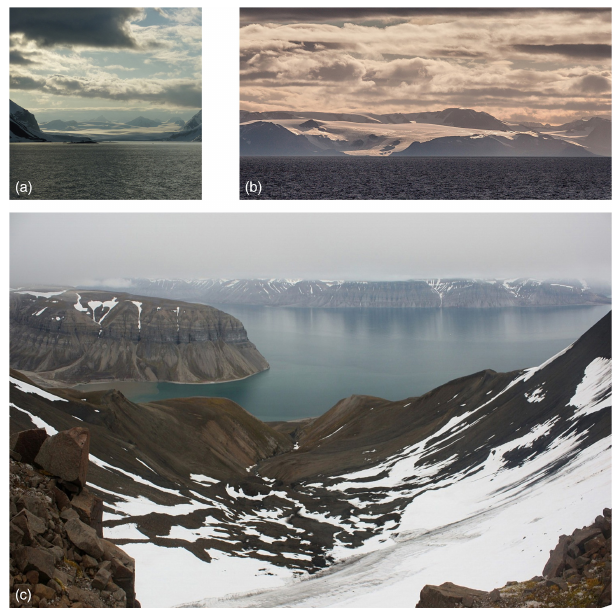
Figure 9. Svalbard landscapes. (a) Hornsund fjord, Spitsbergen, during the RV G.O. Sars expedition 191 under the “Present and past flow regime on contourite drifts west of Spitsbergen Area” (PRE- PARED) Eurofleets 2 project. (b) Ice coverage of the Svalbard is- lands along the northwestern coast during the RV OGS-Explora ex- pedition under the “Petroleum Assessment of the Arctic North At- lantic and adjacent marine areas” (PANORAMA) project. (c) Skan- skbukta bay (on the left), Billefjorden (centre) with (front) Bünsow Land cliffs during the Poli Arctici Skanskbukta base camp field trip by the Northern Rangers group.